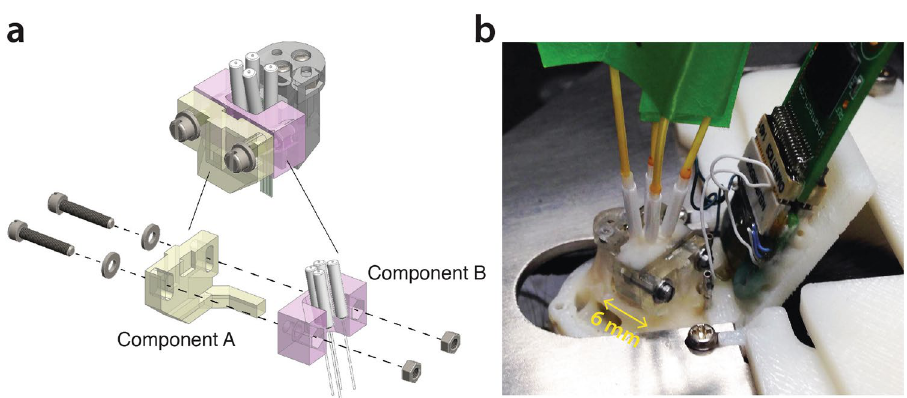
Figure 3. Support for optoelectronic probes. ( a) Fiber connectors are cemented to part B (pink), which is fastened to part A (yellow) by two screws. The screws are loosened and move freely in the slots of part A when the micro-drive is operated to adjust the electrode position in the brain. The screws are tightened before the optical fibers are connected in order to prevent the plugging pressure from altering the electrode position. ( b ) Picture showing the micro-drive and support for optoelectronic probes cemented to the head-plate. Four optical fibers are plugged to the four connectors of the optoelectronic